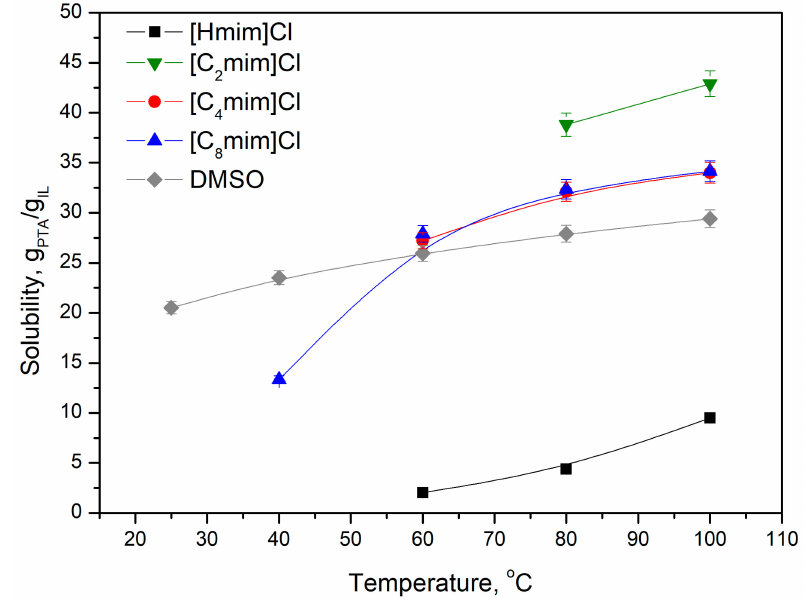
Figure 3. The influence of the alkyl chain length in the 1-alkyl-3-methylimidazolium cation on the solubility of